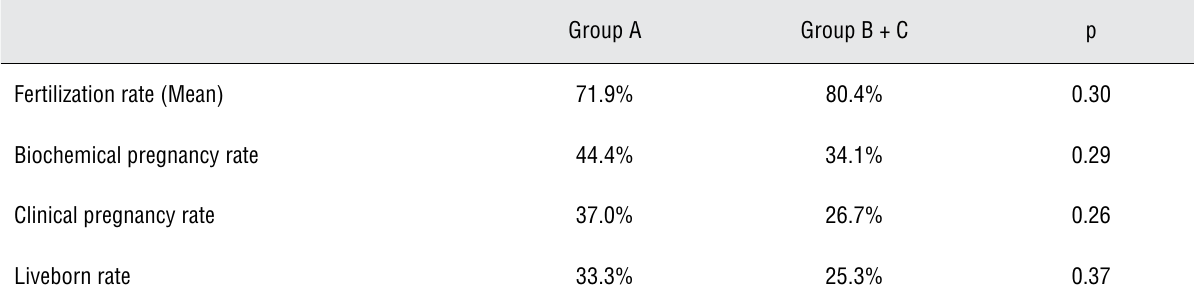
Table 3 - Fertilization and pregnancy rates in the groups and p value for statistical comparison of group A to groups B and C